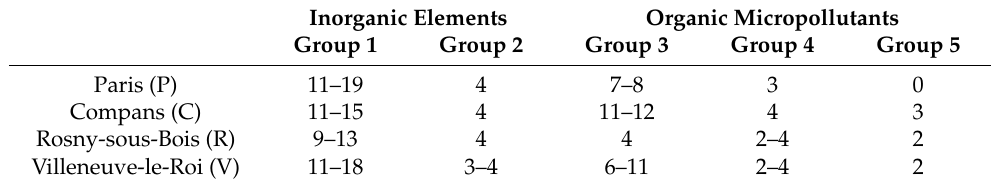
Table 2. Number of rain events analyzed per site and per pollutant group—targeted screening.